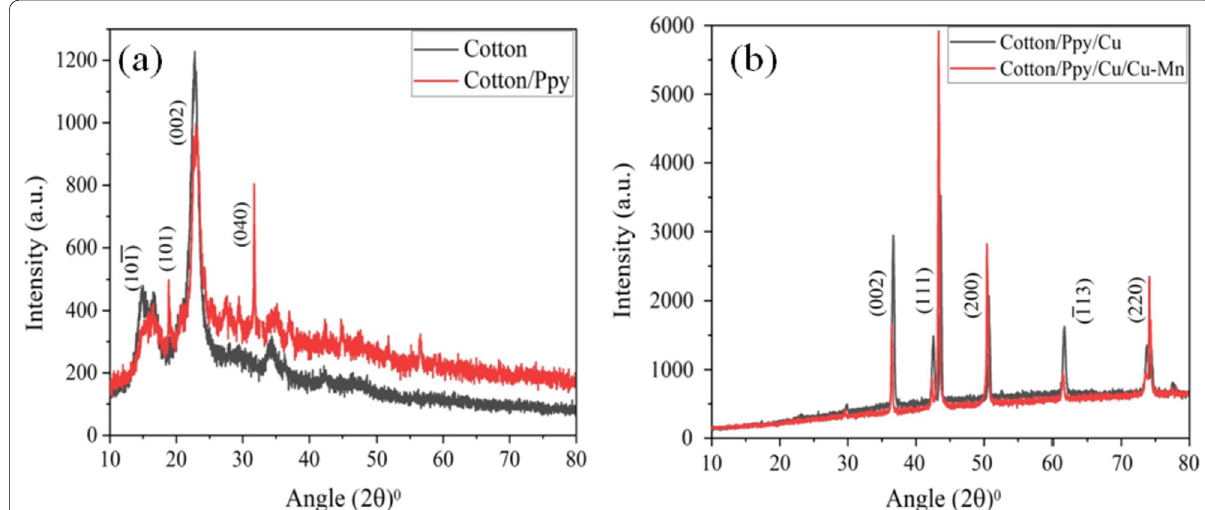
Fig. 2 XRD pattern of a untreated cotton fabric, b ppy/Cu/Cu–Mn-treated cotton